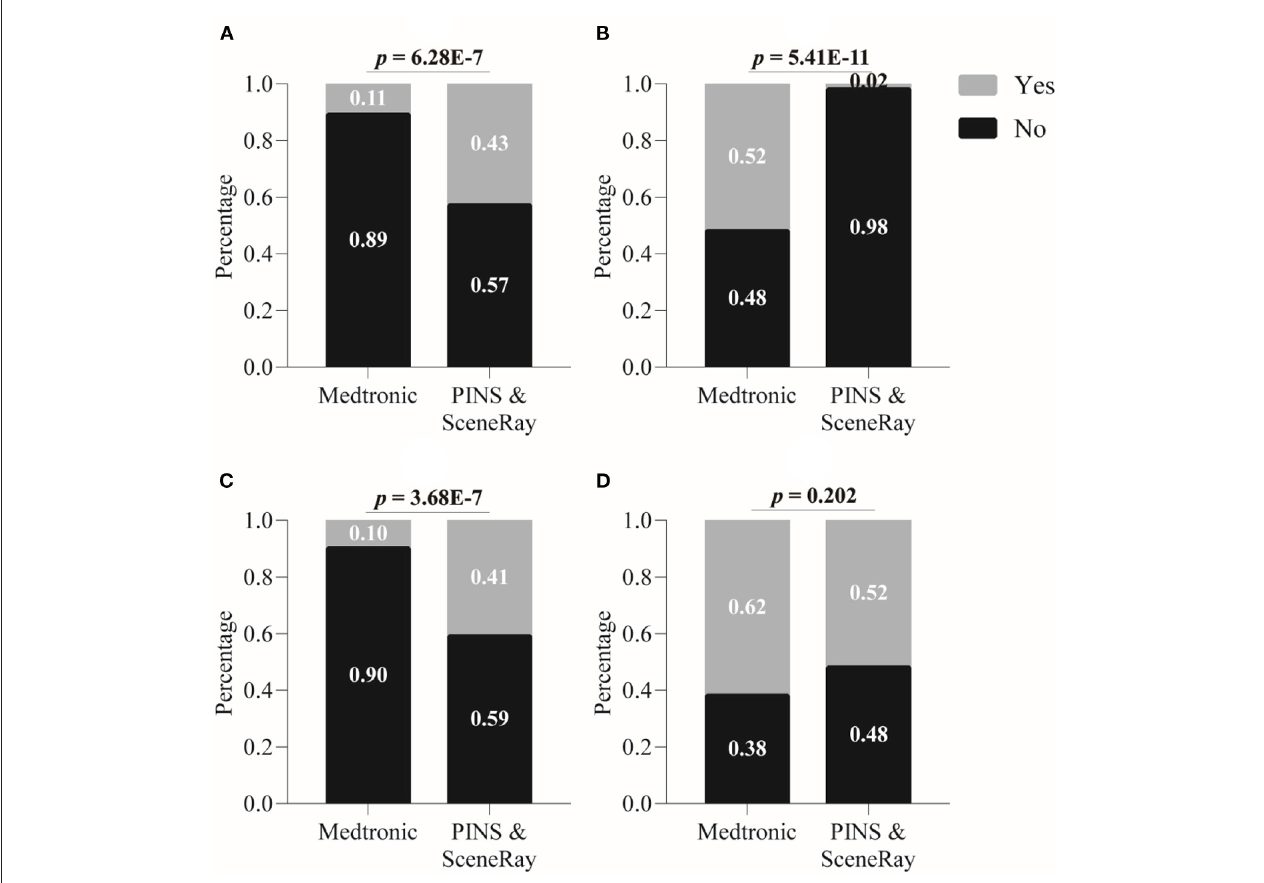
FIGURE 3 | Factors influencing patient’s choice between imported and domestic rechargeable implanted pulse generator (r-IPG). (A) Budget issue; (B) international reputation; (C) remote programming feature; and (D) convenience of postoperative management. Data are presented as percentages. A p -value < 0.05 is considered statistically